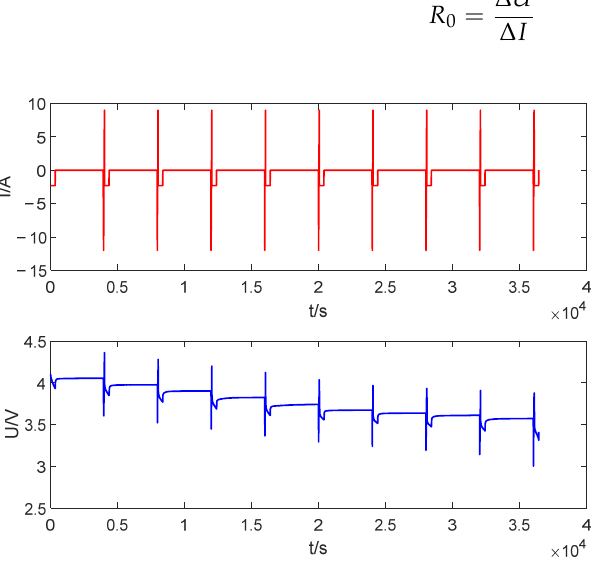
Figure 3. Hybrid pulse power characteristic (HPPC) test.